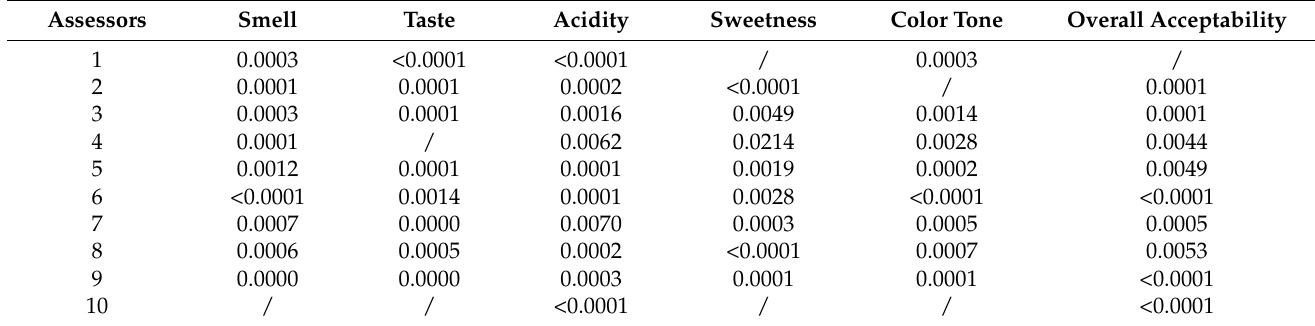
Table 8. ANOVA table of panel analysis parameters (type III sum of squares